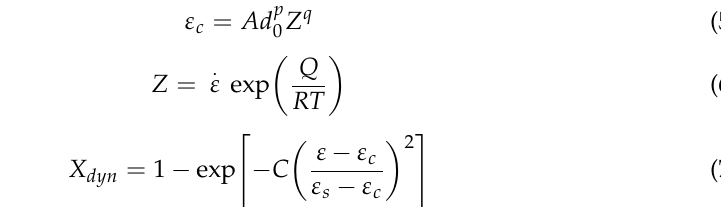
0.101 Figure 2. Temperature distribution of the wire in the furnace. Drawing direction — right to left. 3.3. FEM Simulations The estimation of the conditions of the deformation during the extrusion and hot drawing was a goal of the FEM simulations. A rigid-plastic non-isothermal FE model has been applied. Qform VX (a commercial FE software (ver 9.0, Micas Simulations Limited, Oxford, United Kingdom)) was used for the simulation, similarly as in Biba et al. [32]. In FE codes, recrystallization models were implemented as subroutines written in the pro- gramming language LUA. For the alloy MgCa0.7, it can be assumed that c = 1013.4 + 0.441 t ,  = 1741.4 – 0.173 t and  = 156.32 – 0.023 t , where c ,  , and λ are, respectively, the